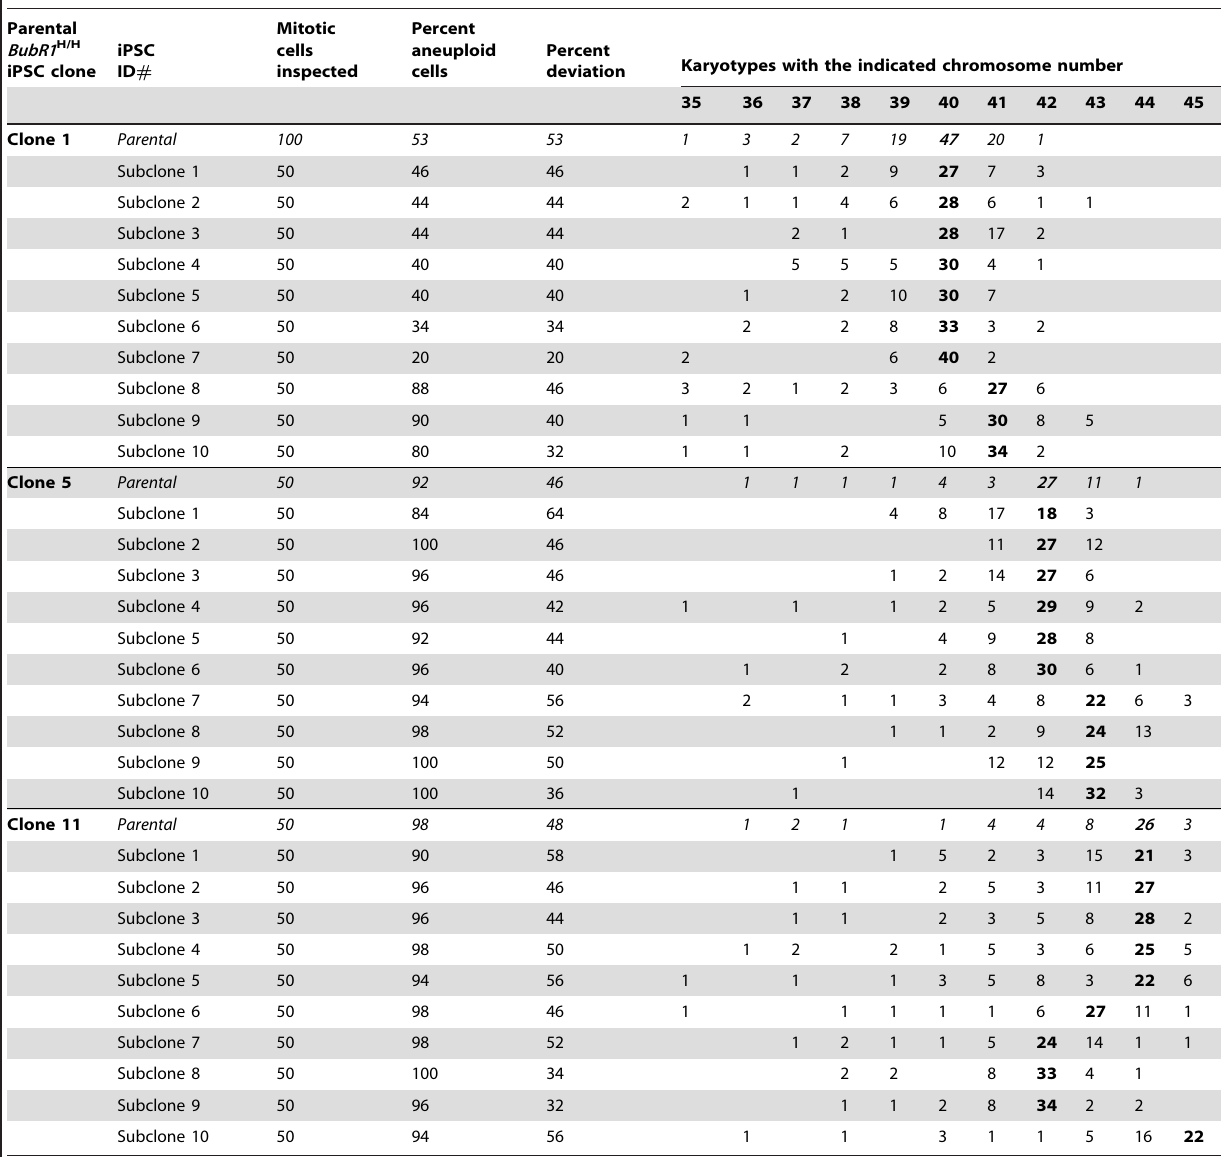
Table 3. Karyotypes of subcloned BubR1 hypomorphic iPSCs reflect the parental kayotype profile.